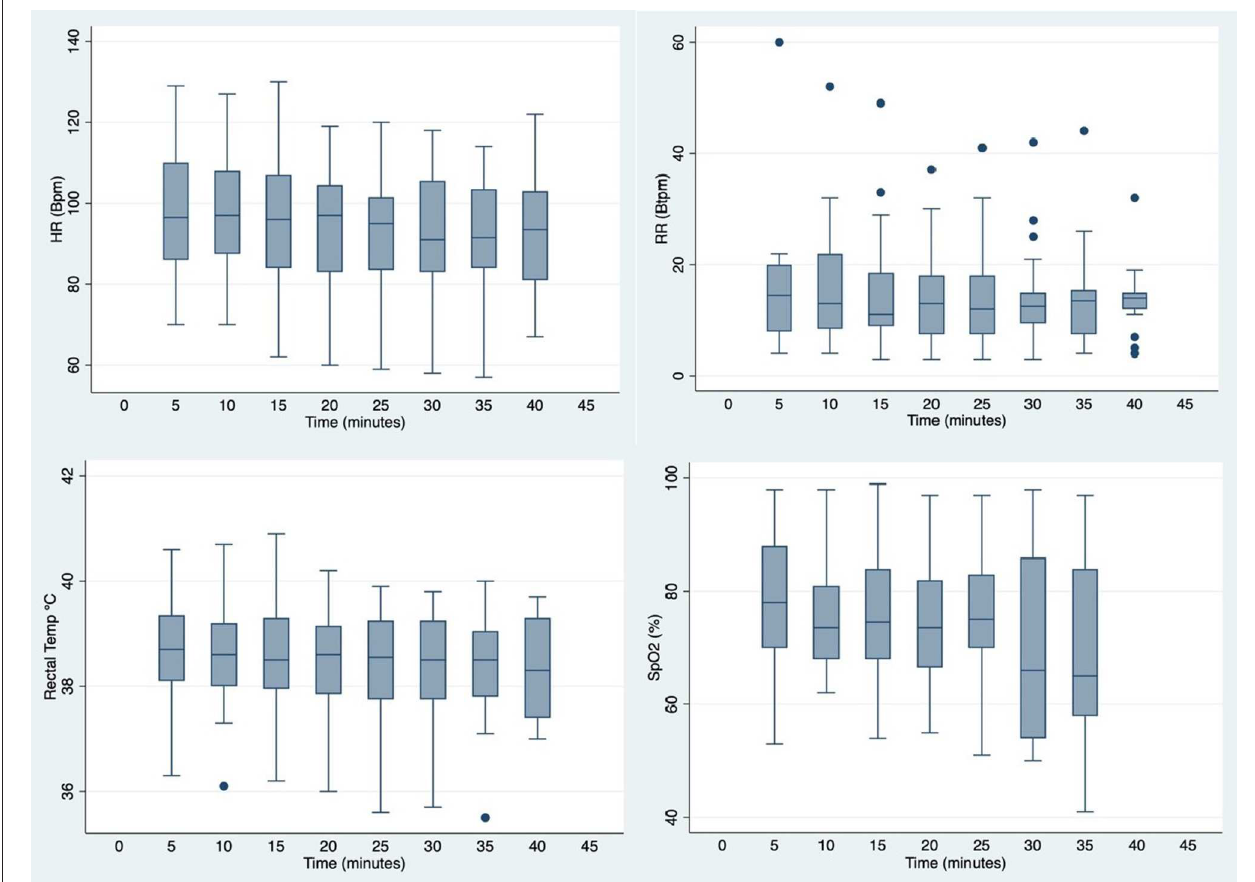
FIGURE 2 | Box plots showing distribution of cardiorespiratory and body temperature values measured at 5min intervals in warthogs (Phacochoerus africanus) immobilized with etorphine, azaperone, and butorphanol. The box represents the interquartile range (25th and 75th percentile) with the horizontal bars inside the box representing median values. The bars represent the lower and upper adjacent values, and outside values are represented by